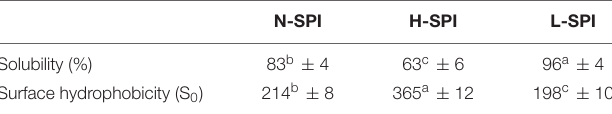
Values are means and standard deviations of three determinations, the different lower case letters (a–c) in the same row indicate significant difference among the values at the p <